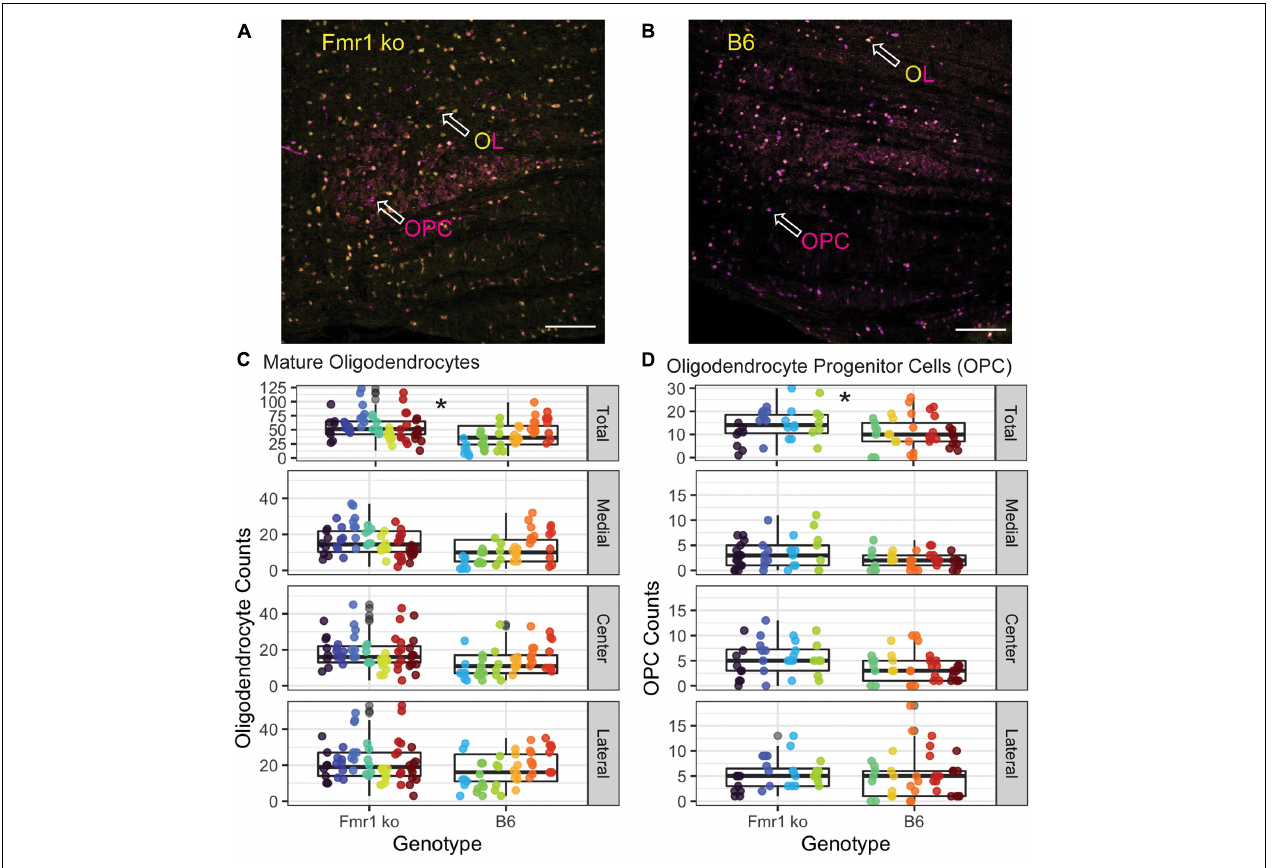
FIGURE 5 | Oligodendrocyte and OPC number are increased in the MNTB independent of tonotopy in Fmr1 KO mice compared to B6. Representative images for OLs (yellow/magenta ASPA/sox-10 marker, arrowhead) and OPCs (magenta sox-10 marker, arrowhead without ASPA (yellow) staining) in Fmr1 KO (A) and B6 (B) mice. Scale bar is 100 µ m. Box plots show data from each individual measurement for Fmr1 KO (left) and B6 (right) for each animal (as indicated by different colors within the boxplots) for the total, medial, center, and lateral MNTB for OLs (C) . N is 7 Fmr1 KO animals and 6 B6 animals. Box plots show data from each individual measurement for Fmr1 KO (left) and B6 (right) for each animal (as indicated by different colors within the boxplots) for the total, medial, center, and lateral MNTB (D) for OPCs. N is 4 Fmr1 KO animals and 5 B6 animals. * p < 0.05.